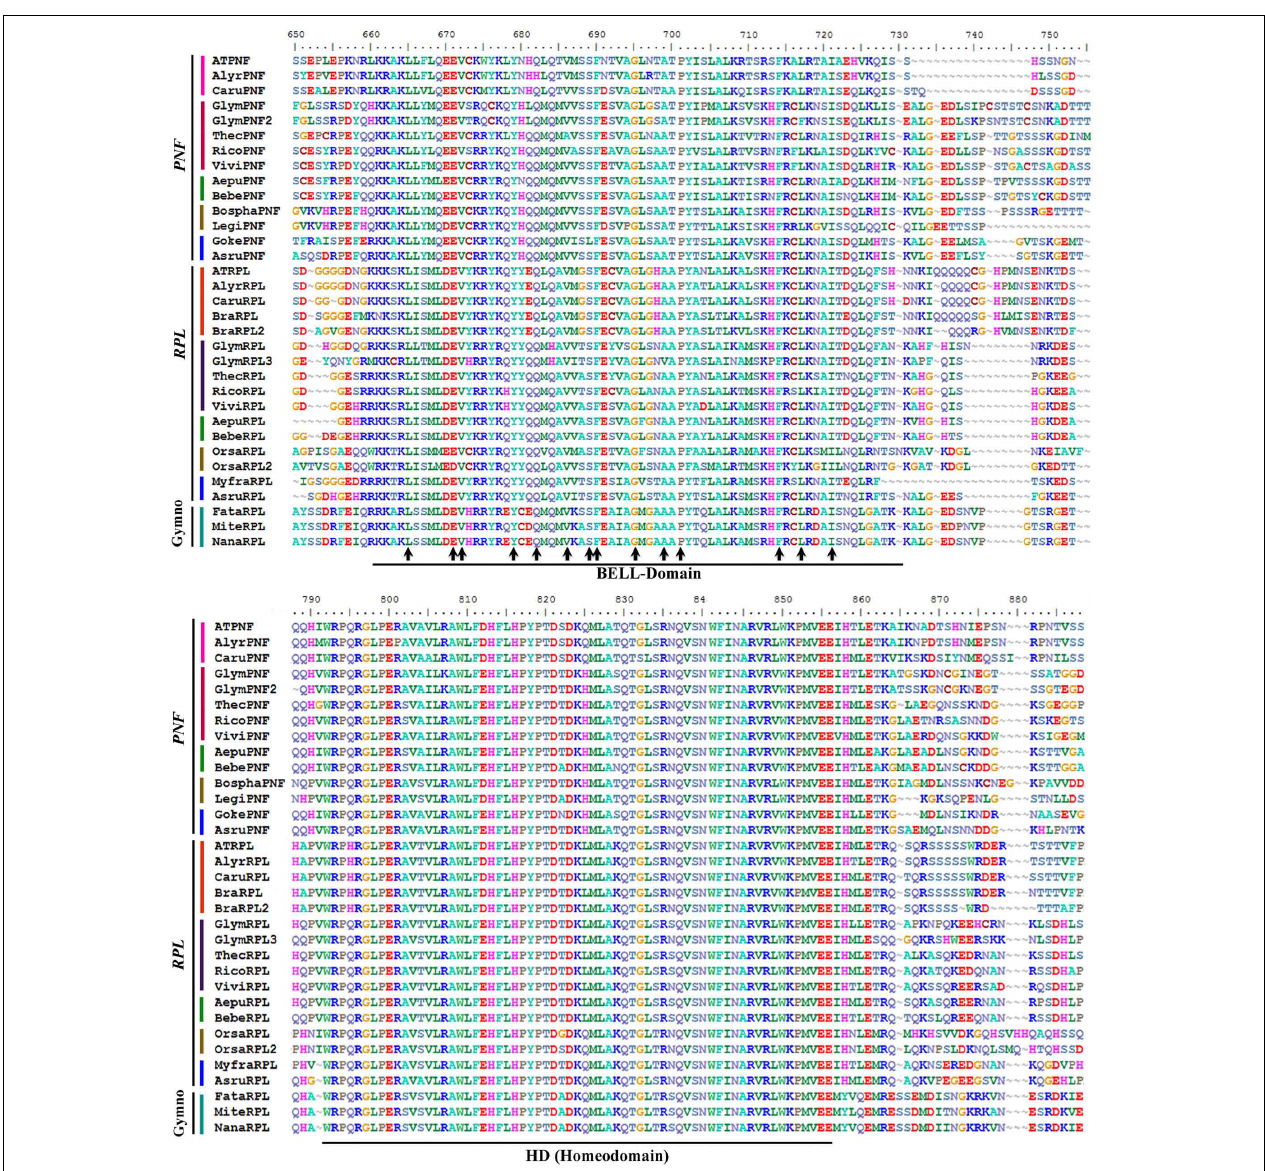
FIGURE 10 | Alignment of the BELL-domain and the Homeodomain of REPLUMLESS / POUNDFOOLISH proteins (labeled with the clade names they belong to). Colors to the left of the sequences indicate the taxa they belong to as per color key in Figure 11 . Two domains are shown: the BELL domain (also called the MEINOX domain by Smith et al., 2002) has some